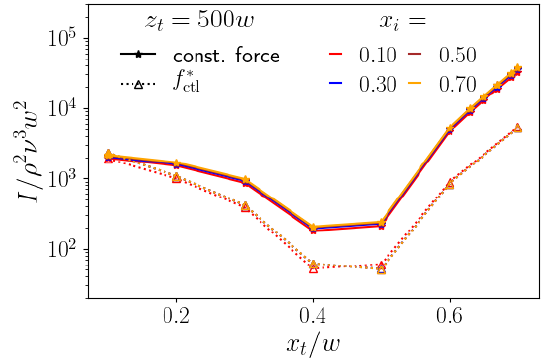
Figure 7. Comparison between the constant-force strategy (solid lines) and the optimal control-force strategy (dashed line), for different inital lateral positions and a channel length z t = 500 w . We show a semi-logarithmic plot of the cost functional I of the axial control force versus lateral target position x t .